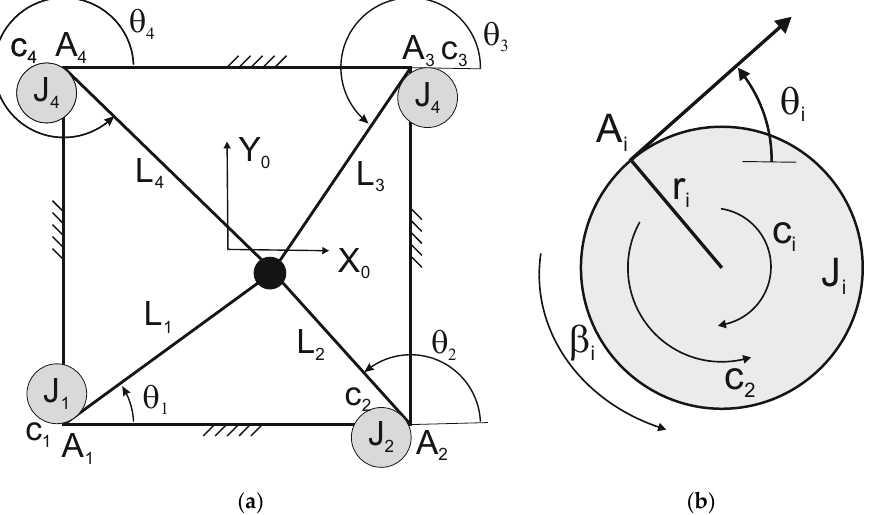
Figure 1. ( a ) Planar four-cable-driven parallel robot structure. ( b ) The structure diagram of the pulley/shaft system. Table 1. Nomenclature of the robot geometric parameters. Parameters